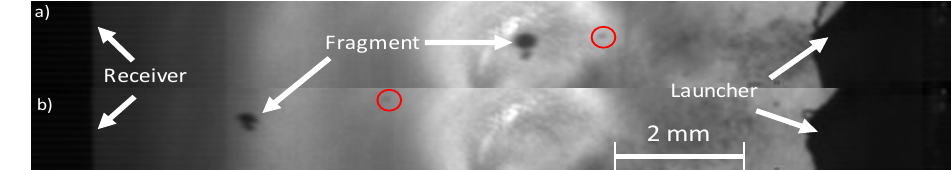
Fig. 5. Two images recorded in LASHPOL experiments. The launcher is on the right and the receiver on the left. The particle is highlighted by a circle and a detached launcher fragment by white arrows. a) 2nd frame recorded (5.5 µs after the laser shock), b) 3rd frame recorded (11.1 µs after the laser shock).